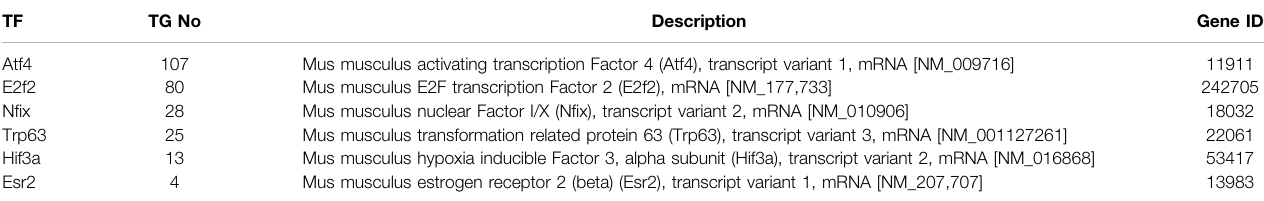
TABLE 1 | Transcription factors and their corresponding target genes.